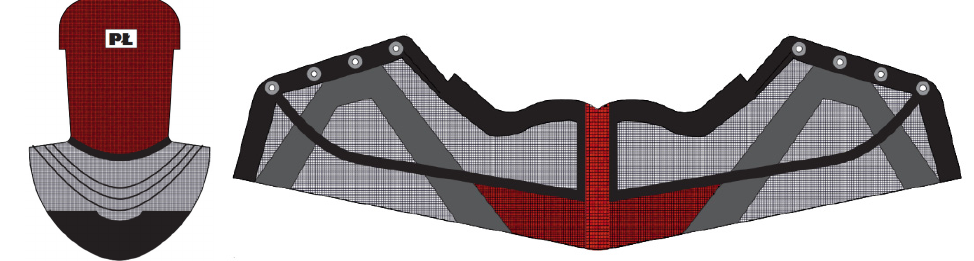
Figure 13. The design projects of the shoe elements made in Corel Draw.